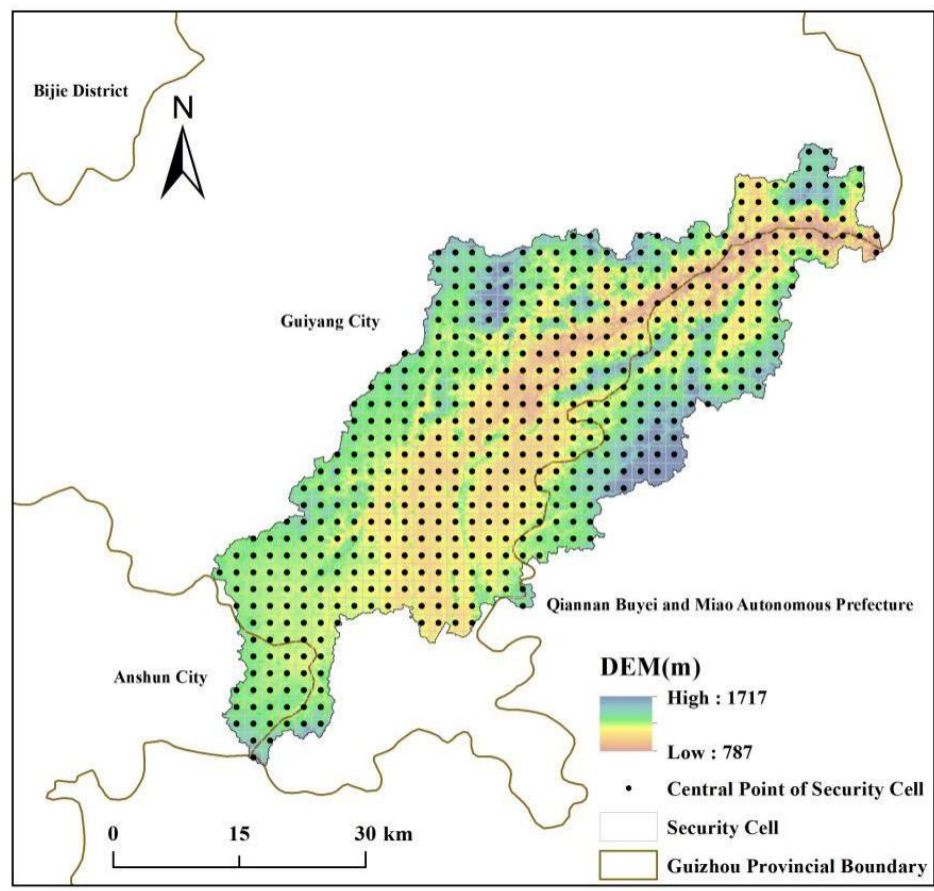
Figure 2. Sampling areas for ecological security assessment of landscape pattern in the study area.